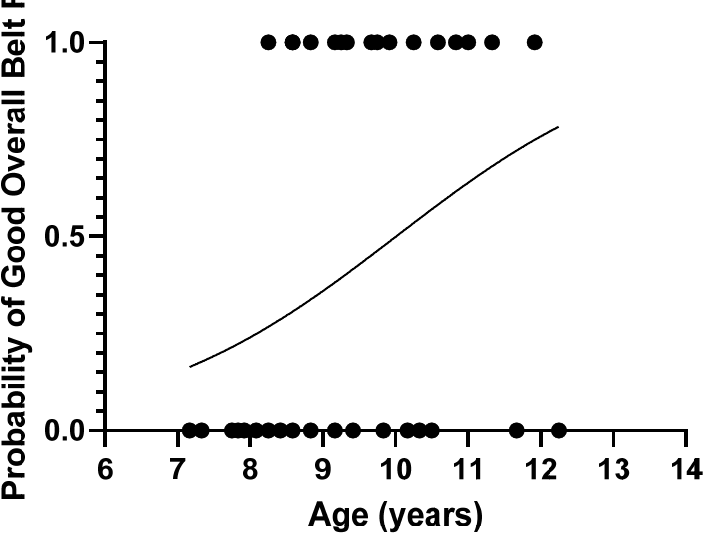
Figure 2. Probability curve for good overall seat belt fit by age of the child. Data points (circles) indicate ages of cases that achieved (1) and did not achieve (0) good overall seat belt fit.